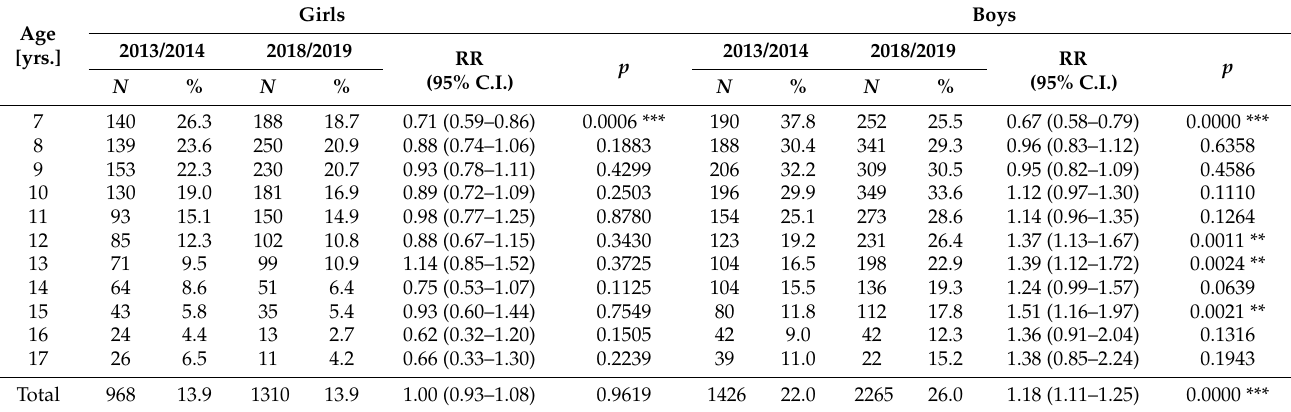
Table 3. Relative risk of overweight/obesity incidence among Ukrainian children and adolescents—2018/2019 vs. 2013/2014. Age